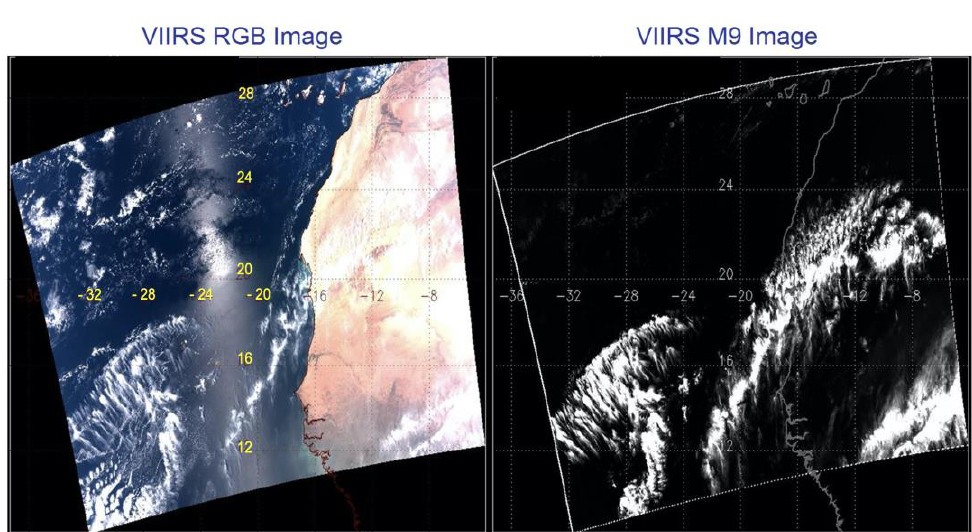
Figure 2. An example of VIIRS images over desert and water areas affected by